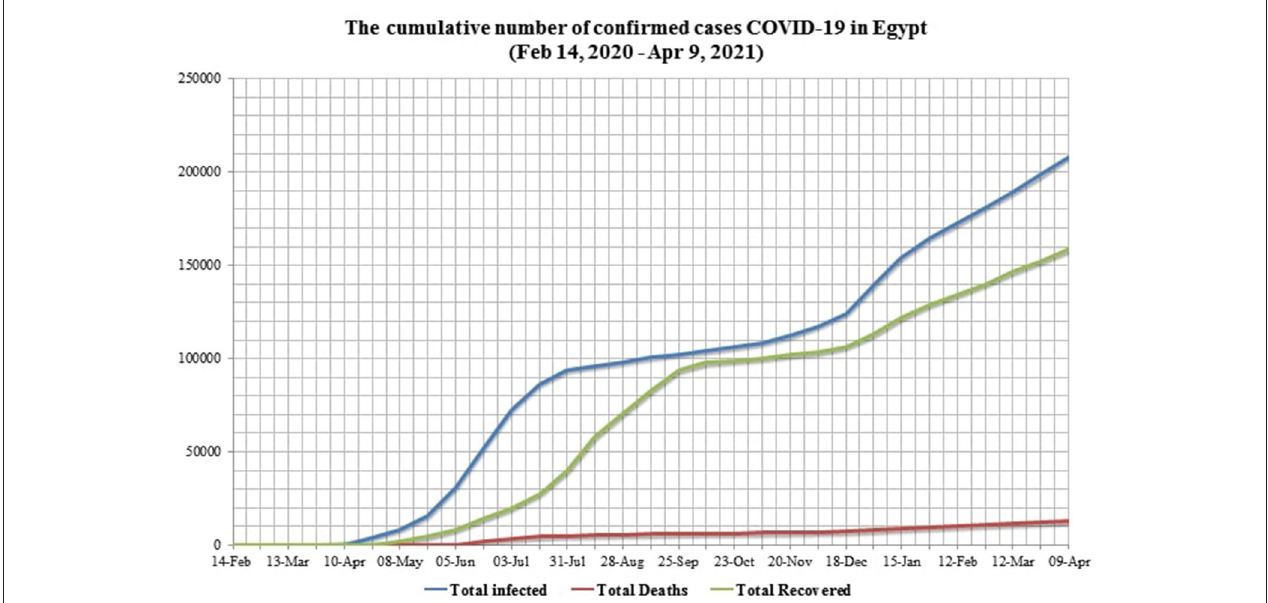
FIGURE 4 | The chart shows the total confirmed cases in Egypt from the first confirmed case on February 14, 2020, till April 9, 2020. In Egypt, the first case of COVID-19 was confirmed on February 14, 2020, while the first death of COVID-19 was on March 8, 2020. Case fatality rate (CFR) reached 7.53% in early April 2020 and then afterward remained stable at around 5%. The percentage of recovered cases slowly increased till reaching 42.13% as of July 2020 and 91.14% as of late September. Recovered cases (RC%) reduced from November 2020 to April 2021 down to 75.24%. Active cases, on the other hand, increased from late